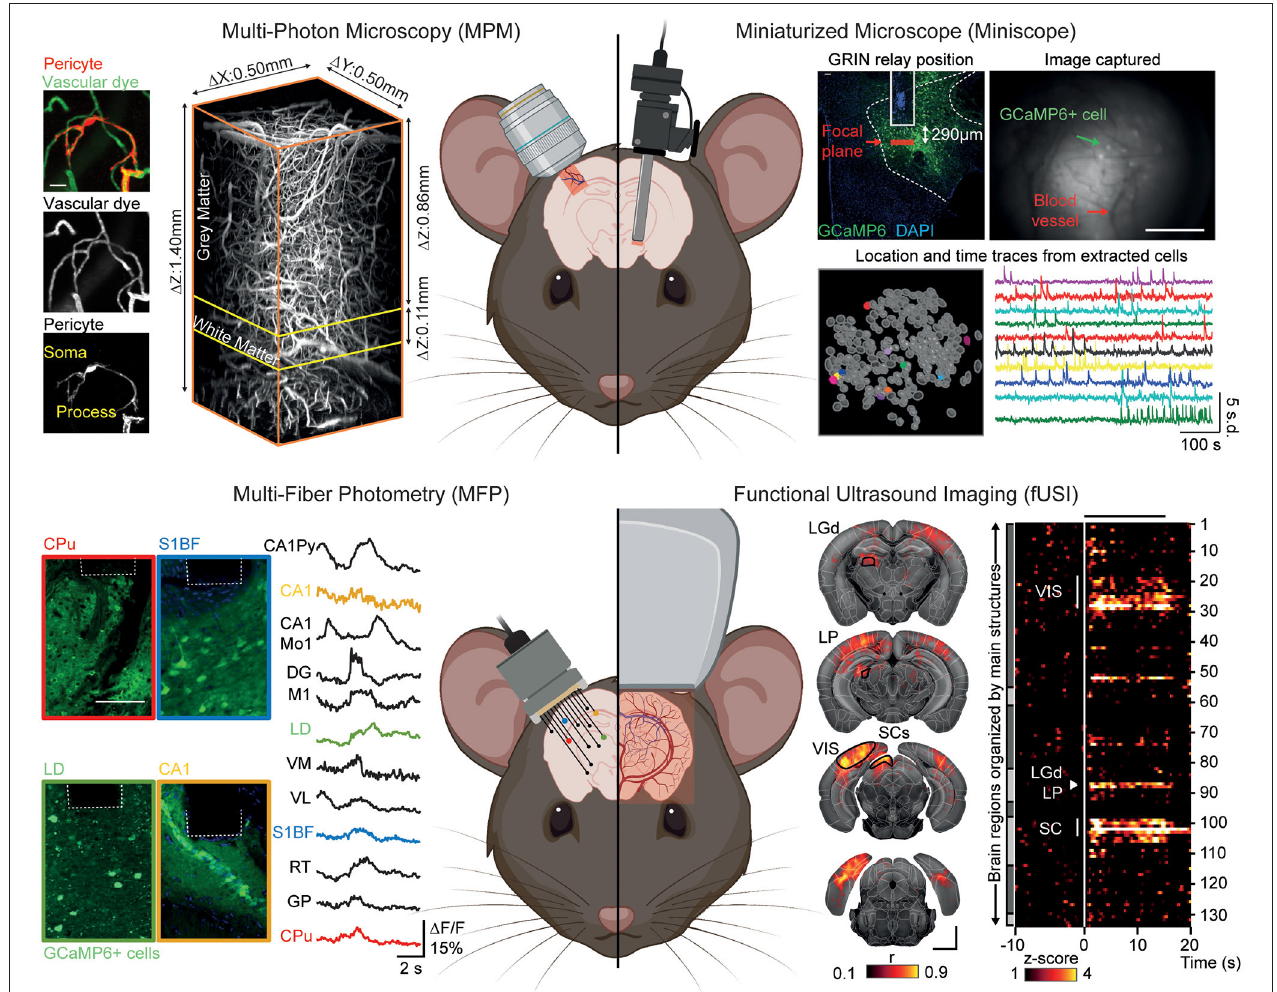
FIGURE 2 | Neuroimaging modalities to investigate the regional heterogeneity of the neurovascular unit under awake conditions. Top left: Multi-photon microscopy (MPM) allows high-resolution imaging of cell-specific activities (here, pericytes) and vascular dynamics using fluorescent dyes in a cortical column and deeper regions. Top right: Miniaturized microscope (Miniscope) suitable for imaging of single cell activity and blood vessels from deep brain regions (here, lateral hypothalamus) by the mean of a GRIN relay. Bottom left: Multi-fiber photometry (MFP) allows for simultaneous recording of cellular changes (here, GCaMP6m-expressing cells) from across, but not limited to, 12 individual brain regions. Bottom right: Functional ultrasound imaging (fUSI) allows for high sensitivity recording of hemodynamic changes with a brain-wide coverage of more than 130 regions per hemisphere. Reprinted with permission from Li B. et al. (2020), Berthiaume et al. (2018), Resendez et al. (2016), Sych et al. (2019), and Brunner et al. (2020). The figure was created using